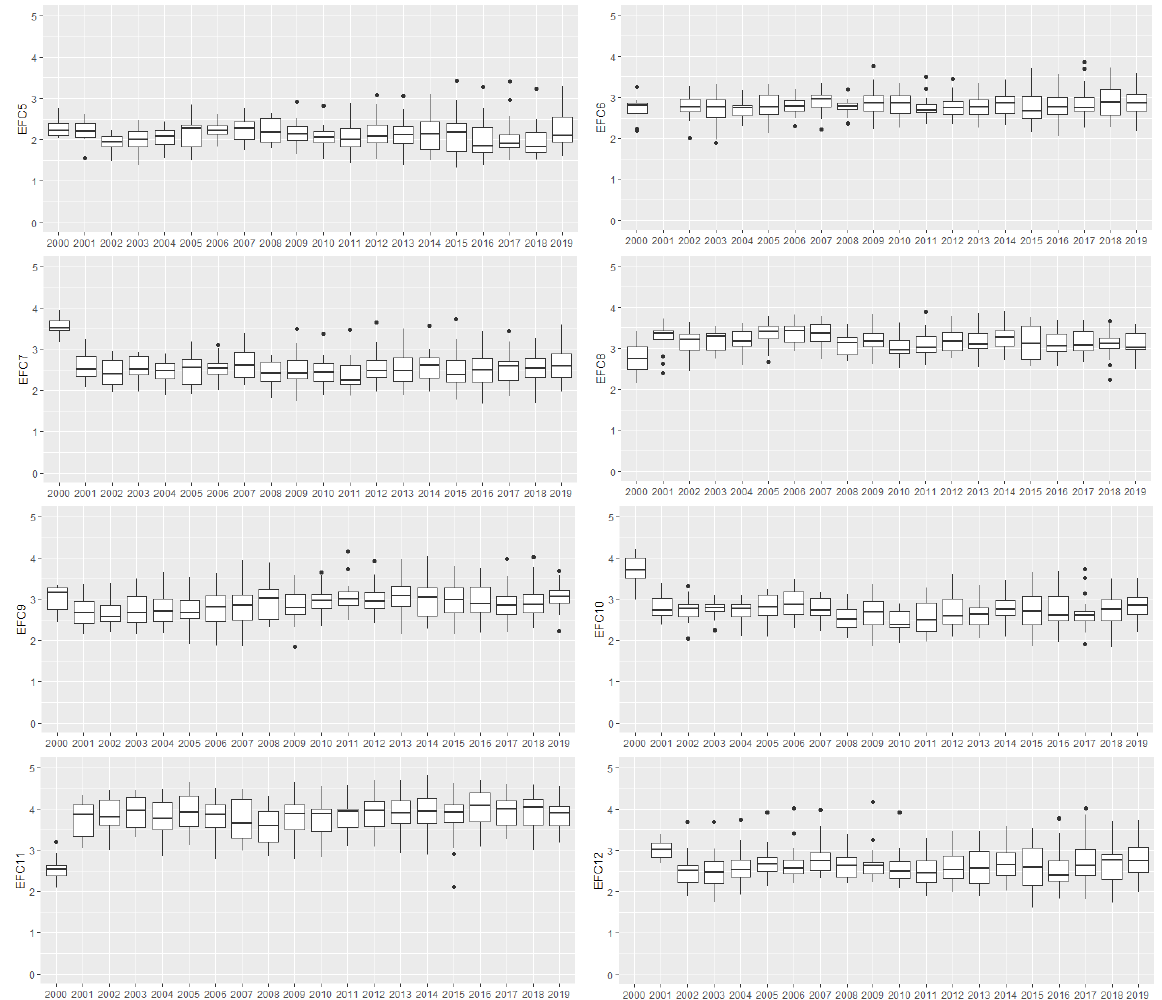
Figure 2. Box plots of the 12 EFCs in the period of